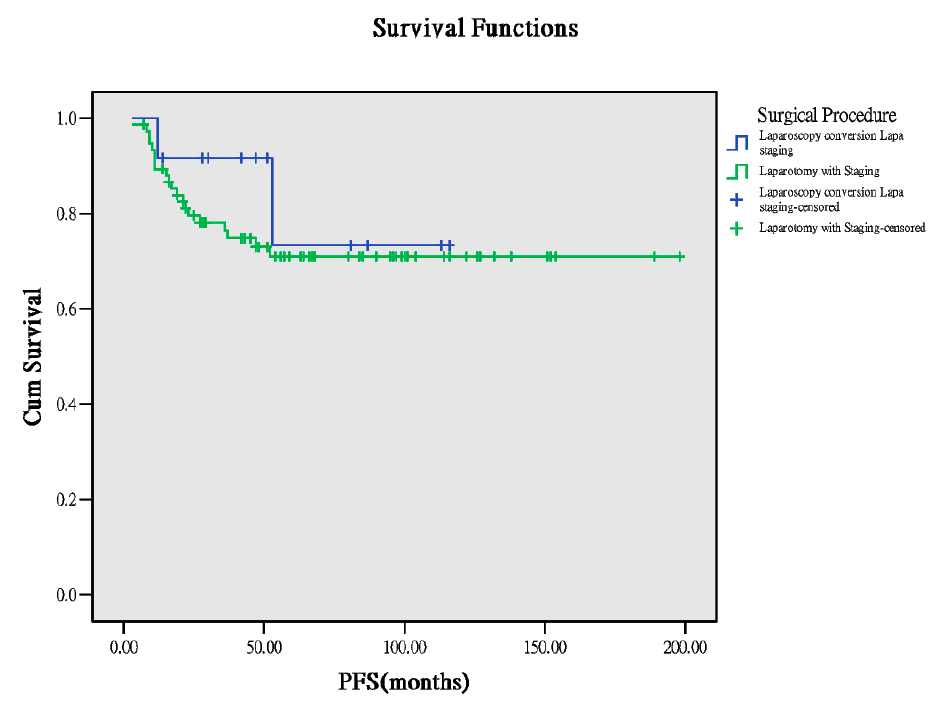
Figure 3. PFS between the surgical approaches ( p = 0.493).